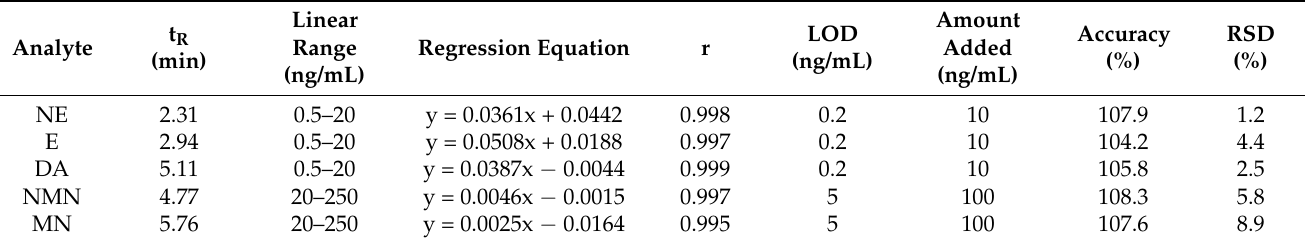
Table 3. Analytical performance of the developed off-line PFSPE–HPLC method for detection of biogenic monoamines and their metabolites in